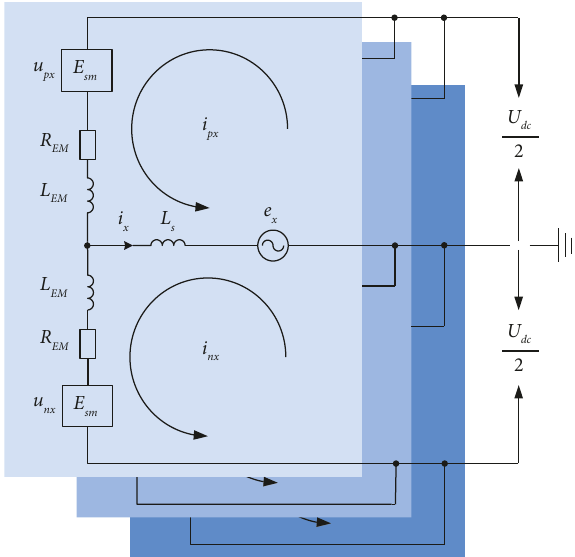
Figure 8: MMC-BESS single-phase equivalent circuit